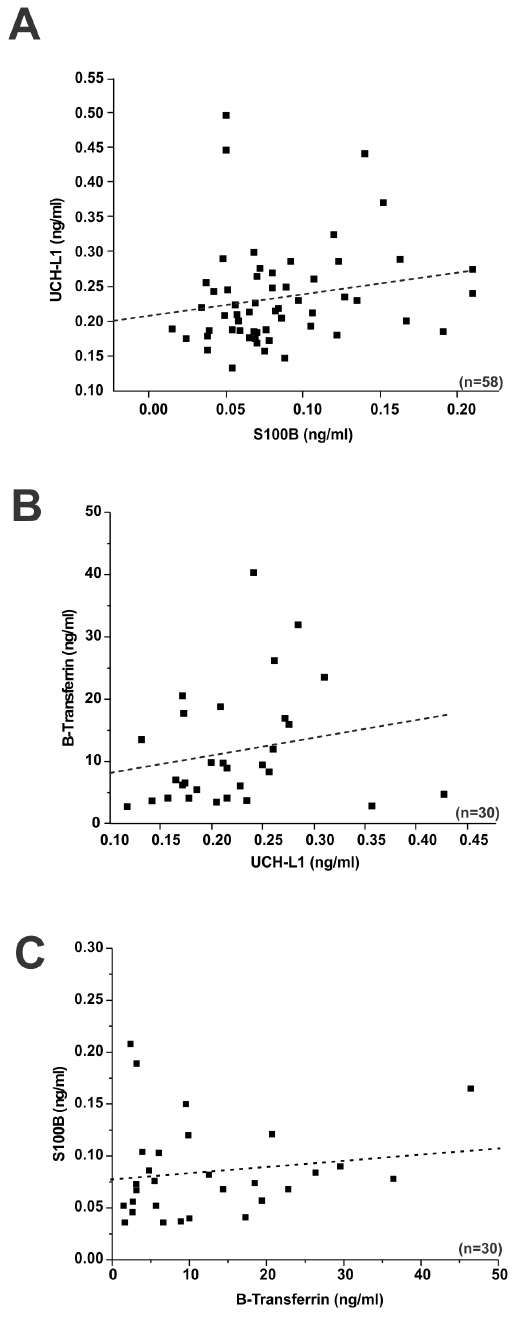
Figure 3. Serum levels of UCH-L1 do not correlate with S100B or levels of b -2 transferrin. A ) S100B serum levels measured at pre- and post- game did not correlate with UCH-L1 serum levels ( p =0.16; R 2 =0.19). B ) Lack of correlation between UCH-L1 or S100B and b -2 transferrin levels. b -2 transferrin serum levels measured at pre- and post- game (two games) plotted against UCH-L1 failed to show a statistically significant correlation ( p =0.28; R 2 =0.20). C ) S100B serum levels measured at pre- and post- game (two games) did not correlate with b -2 transferrin serum levels ( p =0.22; R 2 =0.23). Significance is determined by ANOVA and denoted as (*) for p ,